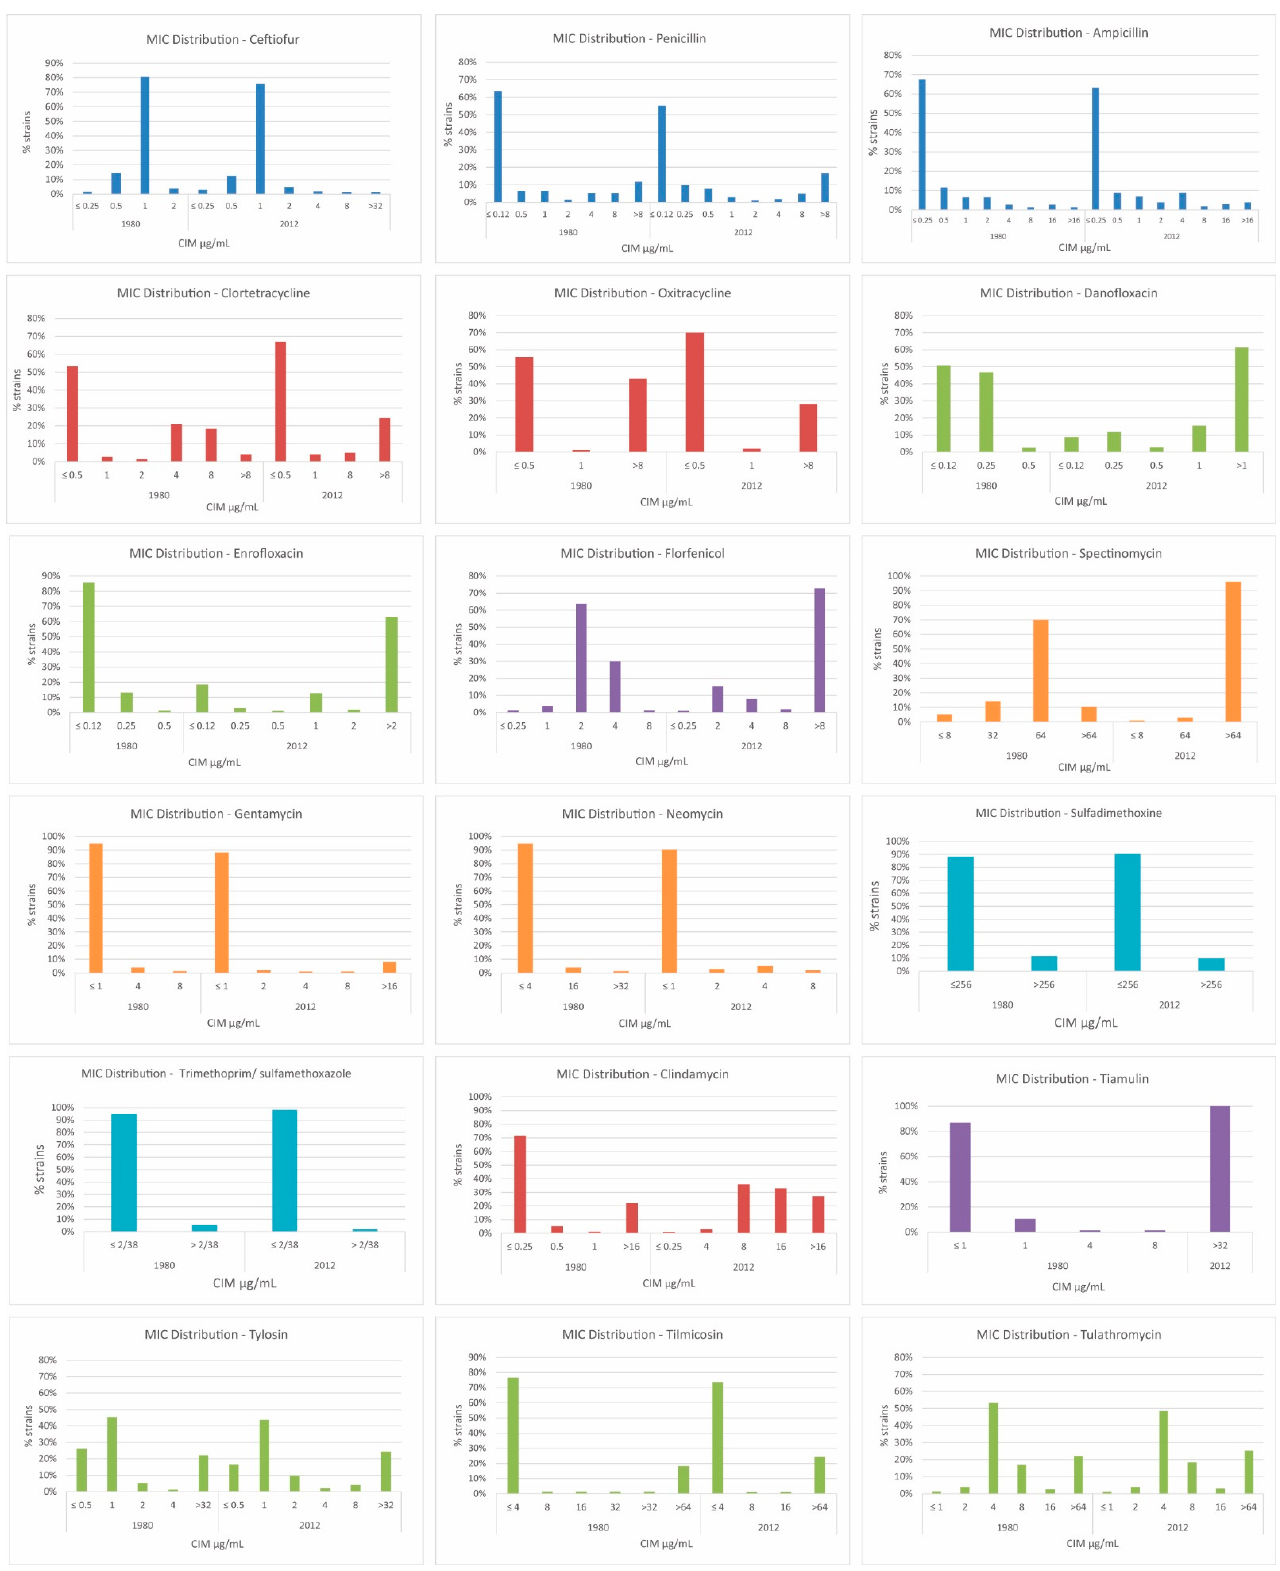
Figure 2. Distribution of MIC values according to antimicrobial tested and period evaluated (1980s or 2012).